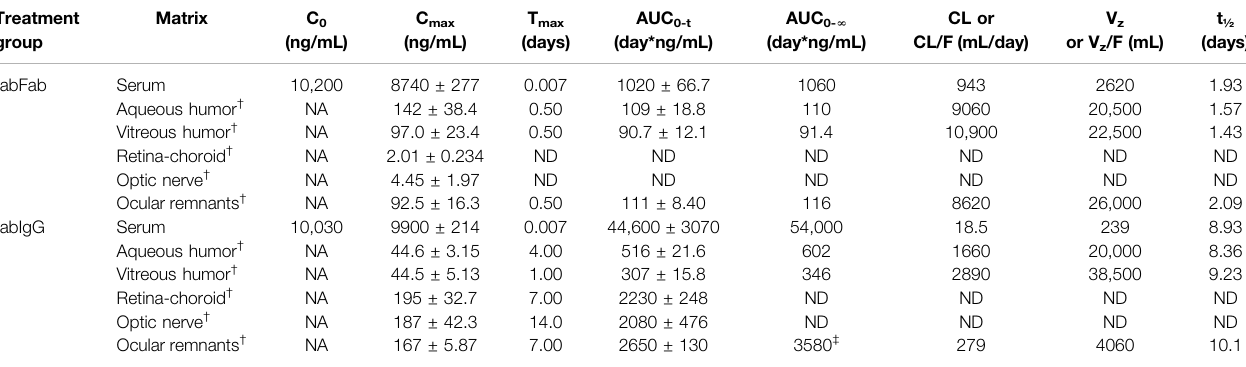
Datapresentedaremean ± standarderrorwhereapplicable;C 0 – Extrapolatedconcentrationattime “ 0 ” ;NA-notapplicable;ND-PKParametercouldnotbecalculatedorreporteddue to insuf fi cient data; † - Reported concentration parameters and AUCs represent ng-eq/mL and day*ng-eq/mL, respectively; ‡ - AUC % extrapolated was > 20%.